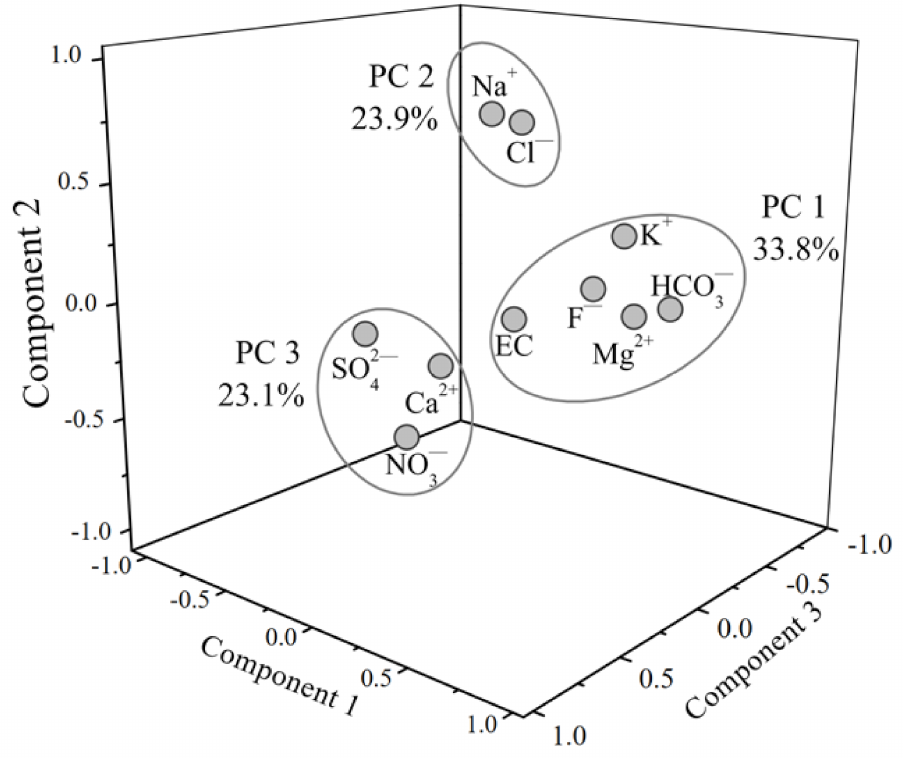
Figure 4. The 3D plot of factor loadings of Chishui River ions and other